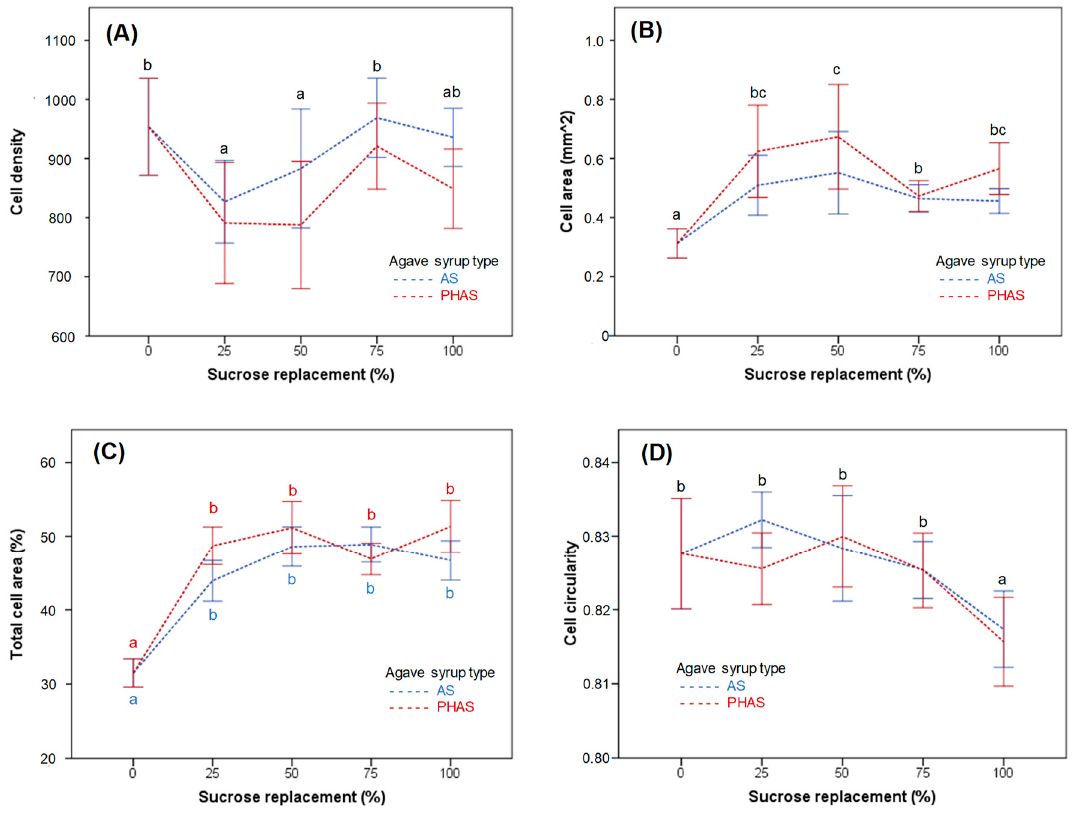
Figure 4. The impact of sucrose replacement by AS and PHAS on the muffin crumb structure, namely cell density ( A ), cell area ( B ), total cell area ( C ), and circularity ( D ). Error bars represent 95% confidence intervals. The different subscript letters of the same color represent Tukey’s homogeneous groups, with significant ( p < 0.05) differences between different sucrose replacement levels for AS (blue letters), PHAS (red letters), or for both types of agave syrup when there was no interaction between the sucrose replacement and agave syrup type (black letters).